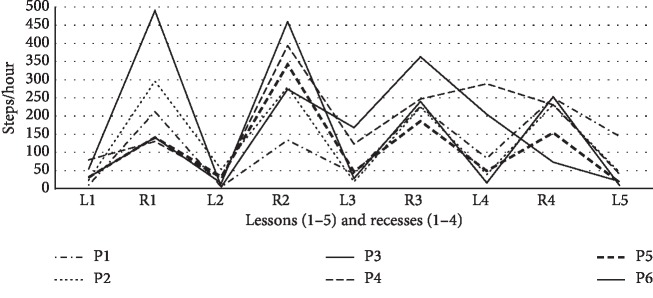
Mean number of steps per hour in lessons (L1–L5) and subsequent recesses (R1–R4) in six participants (P1–P6) who reported academic stress in four or more lessons. L: lesson; R: recess.